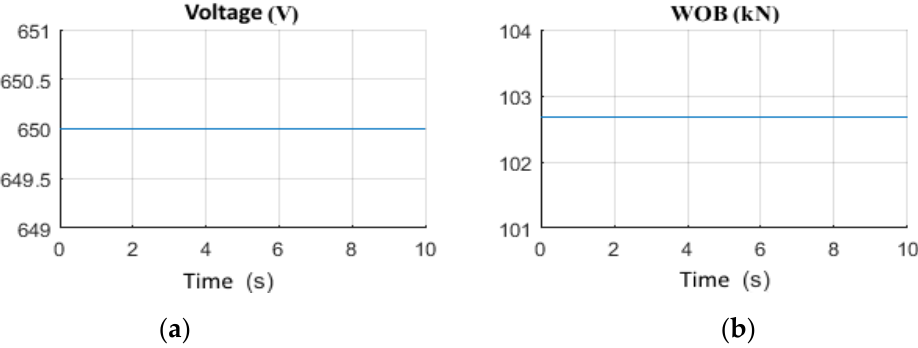
( b ) Figure 17. Measured and estimated variables by the designed observer for Scenario-4: ( a ) Rota- tional velocities, ( b ) Stick-slip severity. ( a ) ( b ) Figure 18. Measured and estimated variables by the designed Observer for Scenario-4: ( a ) Top-drive current, ( b ) Top-drive velocity. 4.2. Scenario5: Disturbed Measurements In this scenario, the system has been driven with a constant voltage equal to 650V and constant Wob equal to 103 kN, as demonstrated in Figure 19a,b. Then, disturbances have been introduced to the top drive current and velocity with non-zero mean signal with frequency of 1kHz as given in Figure 20a,b [48]. As expected, the H ∞ observer has arrived to filter the unstructured perturbations unlike other observer, such as the Kalman filter. This is mainly caused by the supposition put on the choice of covariance matrices, whilst H ∞ design did not require any restrictions in terms of their choices. Figure 21a,b show the estimated velocity and torque of the drill bit, and Figure 22a,b demonstrates the